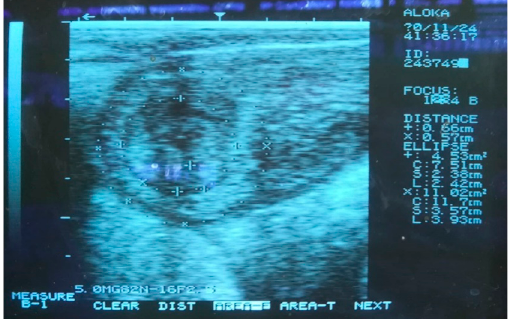
Figure 5. Cross-sectional ultrasound image of the uterine horn (Aloka SSD-500).